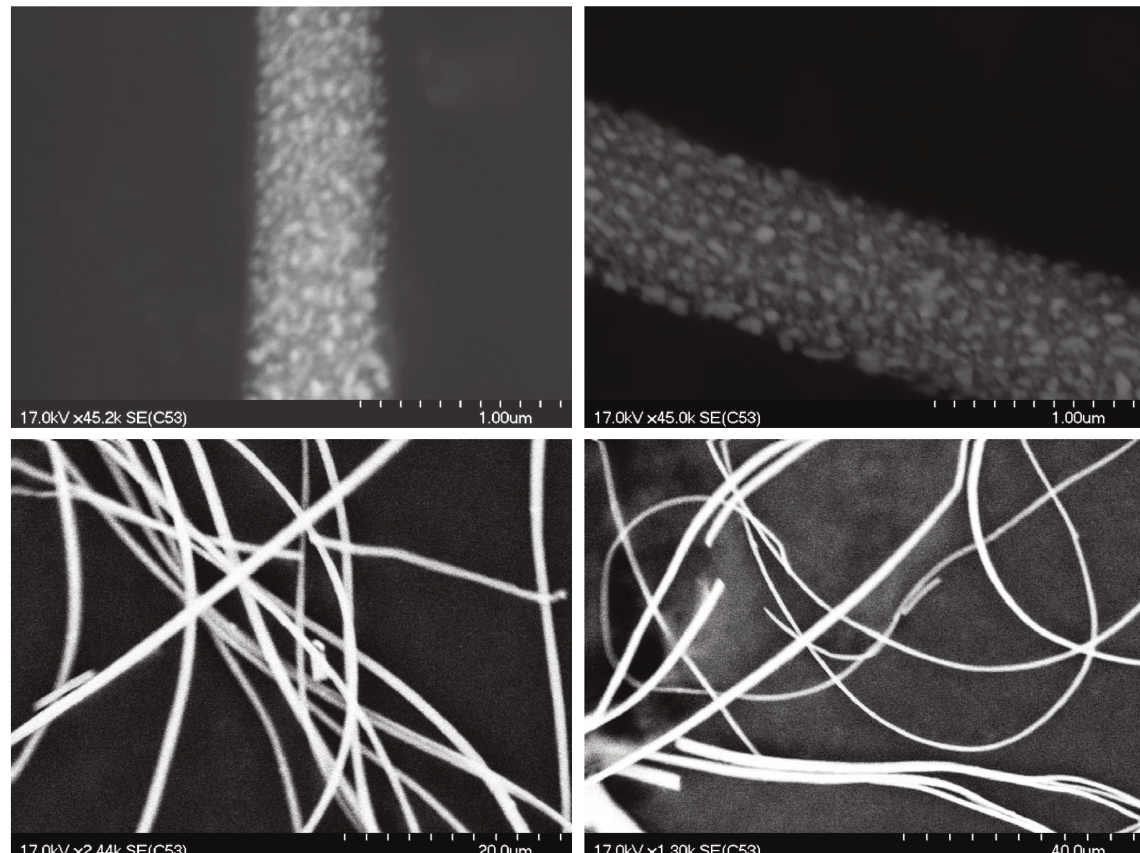
Figure 4: SEM images of as-spun TaC fibers after carbonization.